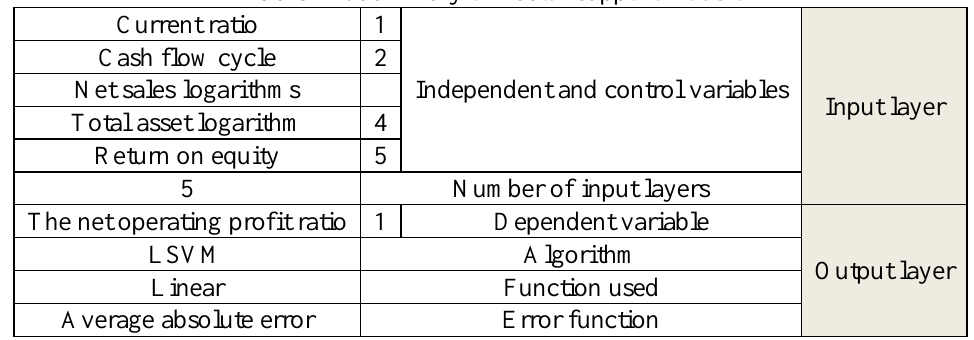
Table 11. Summary of vector support model.